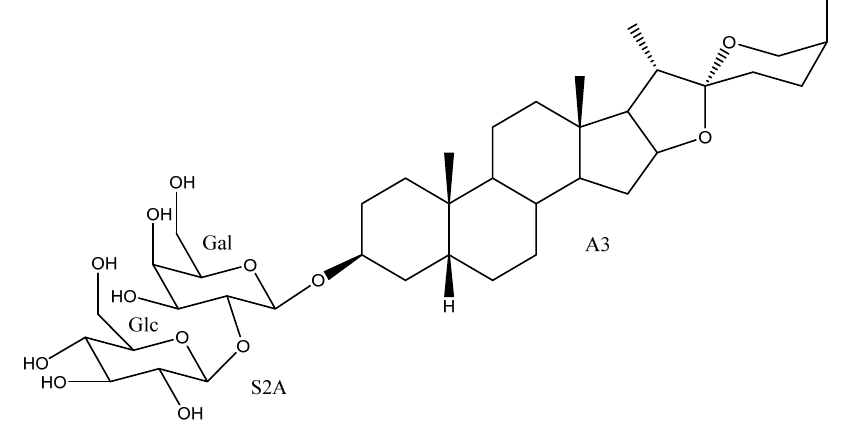
Figure 11. Timosaponin AIII ( 20 ).